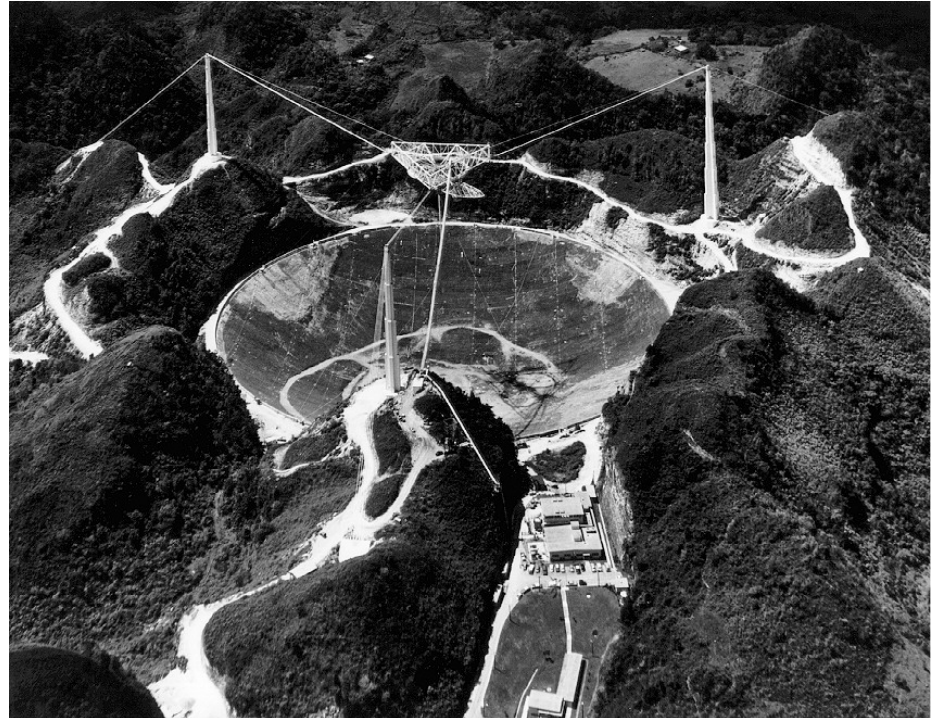
Figure 3. AIO at about the time it was dedicated on 1 November 1963. Note the 430MHz linefeed projecting below the elevation arm – see Fig. 5 for a close-up picture of this linefeed. The waveguide from the transmitter located in the left side of the building nearest the dish is mounted above the catwalk that reaches from the triangle to near the base of the tower nearest the buildings and is then seen to reach from this point to the top of the cli ff above the transmitter / operations building. Photo courtesy of Cornell University and Arecibo